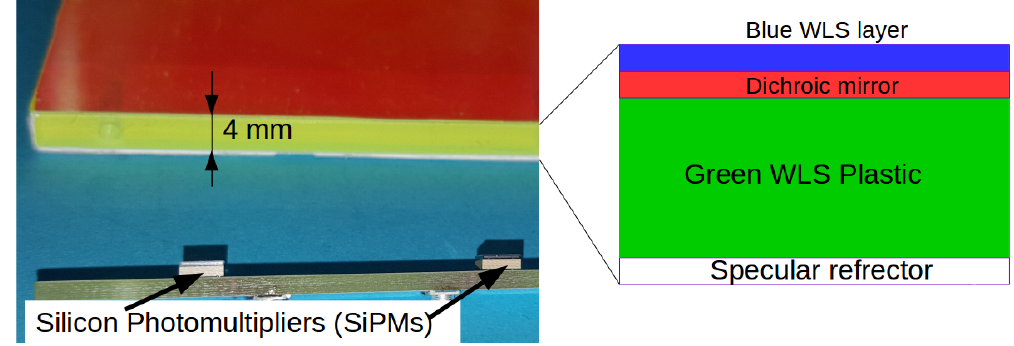
Figure 2. The ArCLight light collector cross section near the corner. Structure is mechanically supported by 4-mm thick wavelength shifter (WLS) plastic (EJ-280) plate. Front side is covered with dichroic mirror film (3M DF-PA Chill) and the first WLS layer (TPB). At the back side 3M Vikuiti Enhanced Specular Reflector is attached. Two out of four SiPMs (Hamamatsu S13360-3050VE) soldered to their carrier PCB are also shown, separate from the light collector.